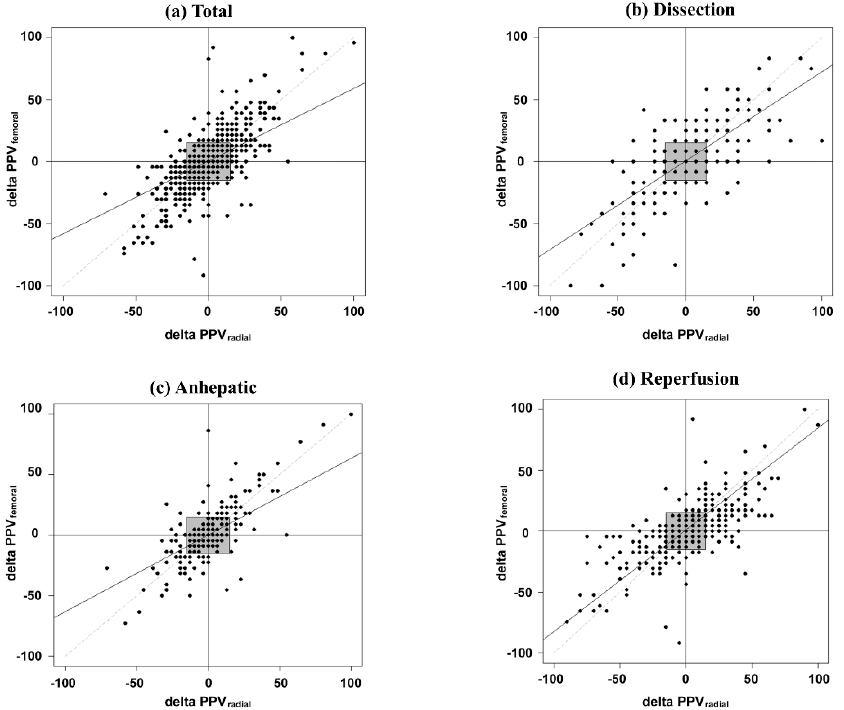
Figure 2. Four-quadrant plot to estimate the concordance rate between PPV-radial and PPV-femoral. The gray square is the central exclusion zone.